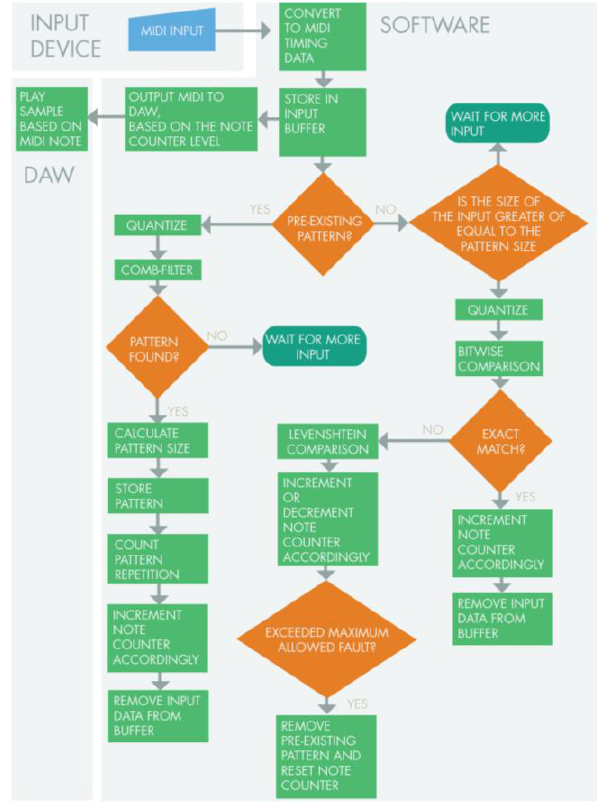
Figure 2. A flow chart depicting the system-level view on the Varianish core